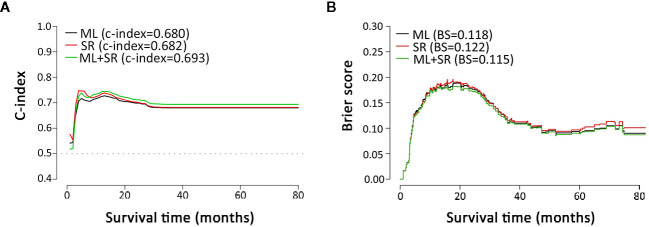
Metrics comparison of models based on different multivariate analysis approaches. (A, B) are C-index and brier score comparisons of models based on multivariate analysis by ML, SR, and ML+SR, respectively. ML, machine learning; SR, stepwise regression.